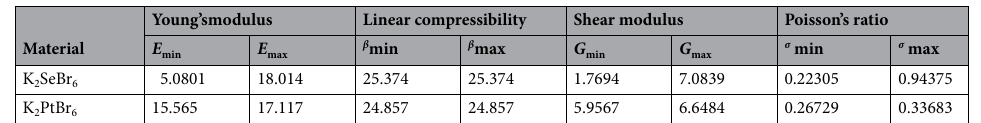
Table 2. The extreme values of Young’s modulus (GPa), linear compressibility (GPa), shear modulus (GPa) and Poisson’s ratio for K 2 XBr 6 (X = Pt,